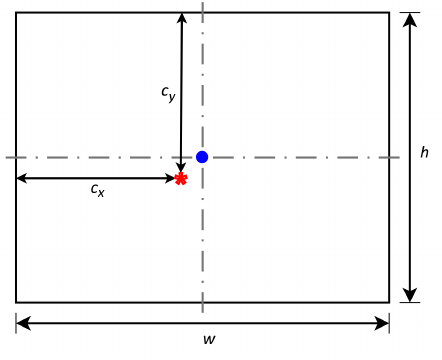
Figure 4. Visual representation of the principal point.